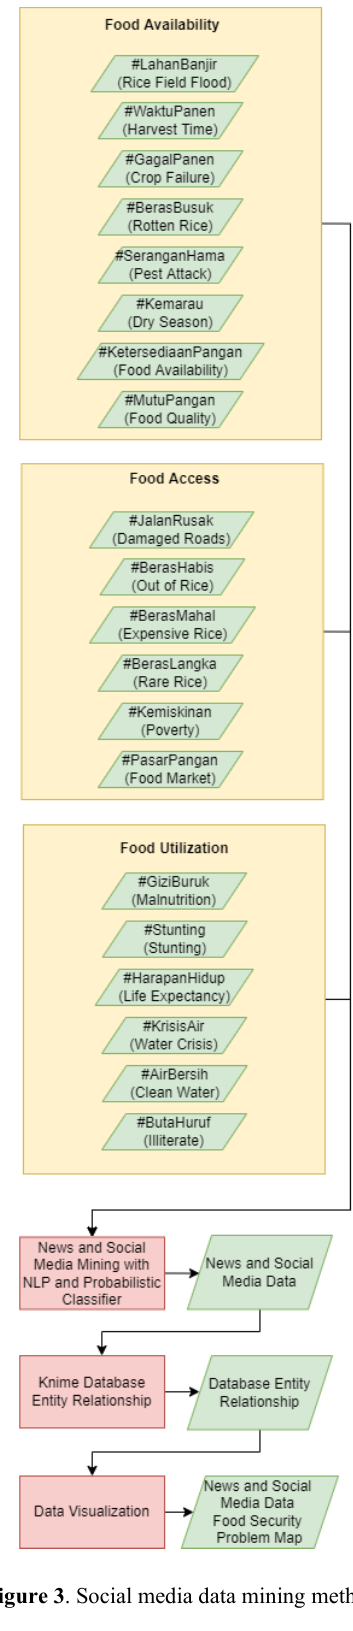
Figure 3 . Social media data mining